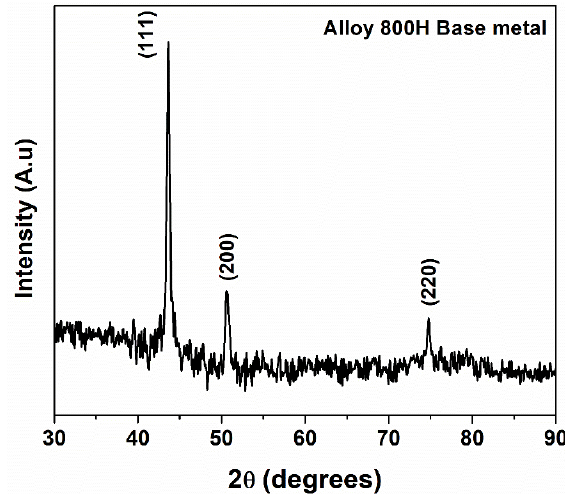
Figure 2. The XRD diffraction pattern of the alloy 800H base metal.